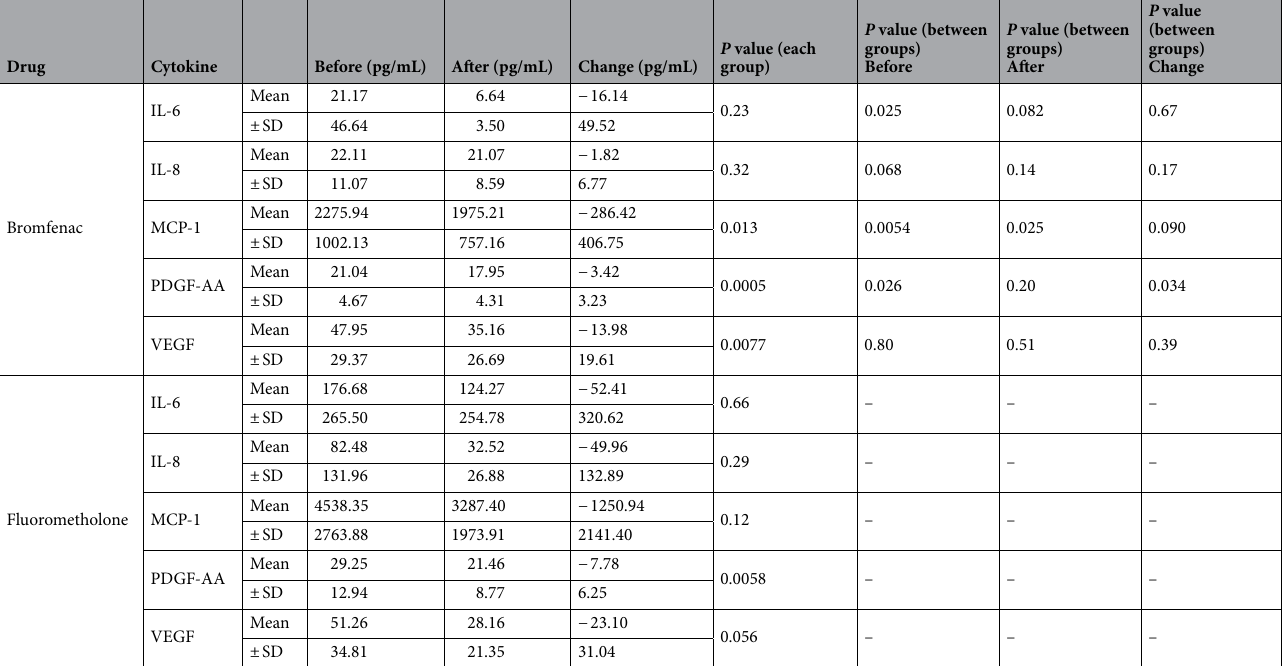
Table 2. Changes in cytokine levels after drug administration. The paired t test was used to analyse the changes in cytokine levels before and after the administration of each drug. The differences in cytokine concentrations before and after drug administration between the drug groups were analysed using Student’s t test. Results with P < 0.05 were considered statistically significant. SD standard deviation, IL